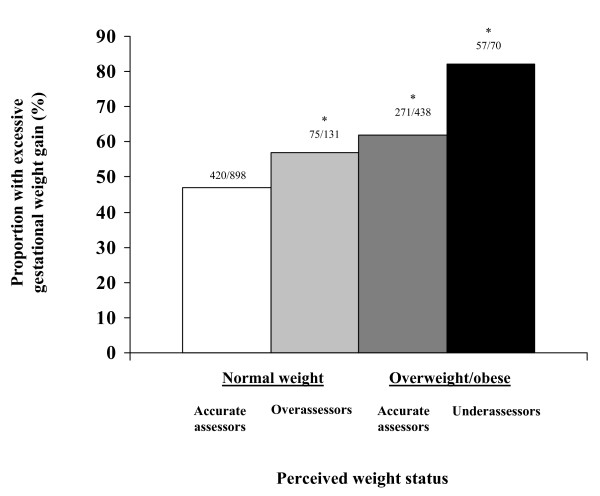
Proportion of women with excessive gestational weight gain according to pre-pregnancy perceived weight status. *P < 0.05 for comparisons to normal weight accurate assessors, via chi square test.